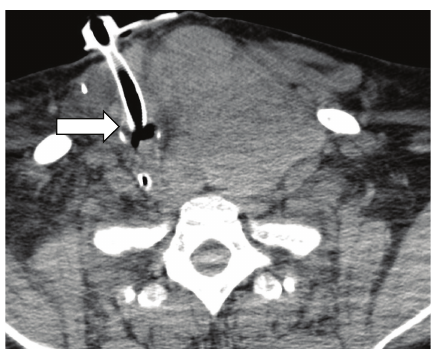
Figure 2: Tracheal deviation and narrowing (transverse view). Also seen is the tracheostomy tube.